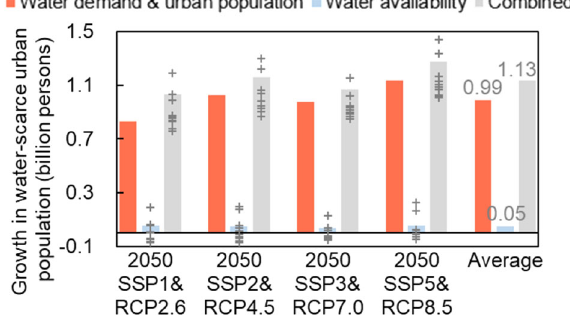
Fig. 4 The effects of different factors on growth in global urban population exposed to water scarcity from 2016 to 2050. Bars present the simulated results using the ensemble mean of runoff from GCMs, crosses present the simulated results using runoff from